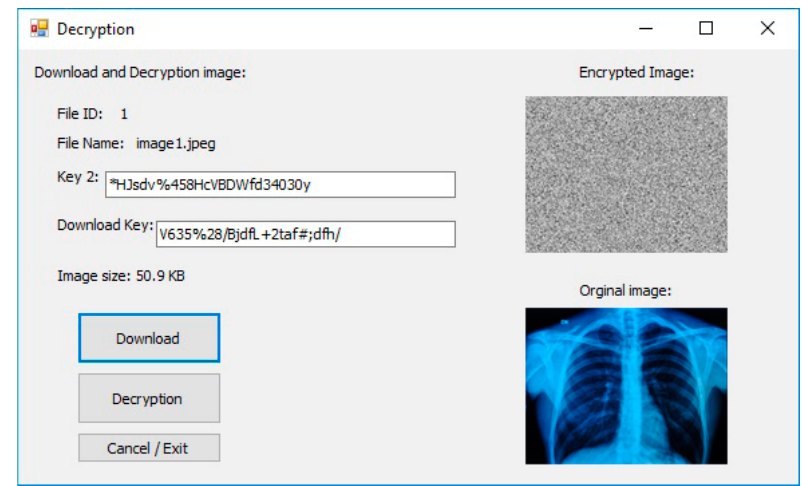
Figure 7. Selected file and encrypted image.